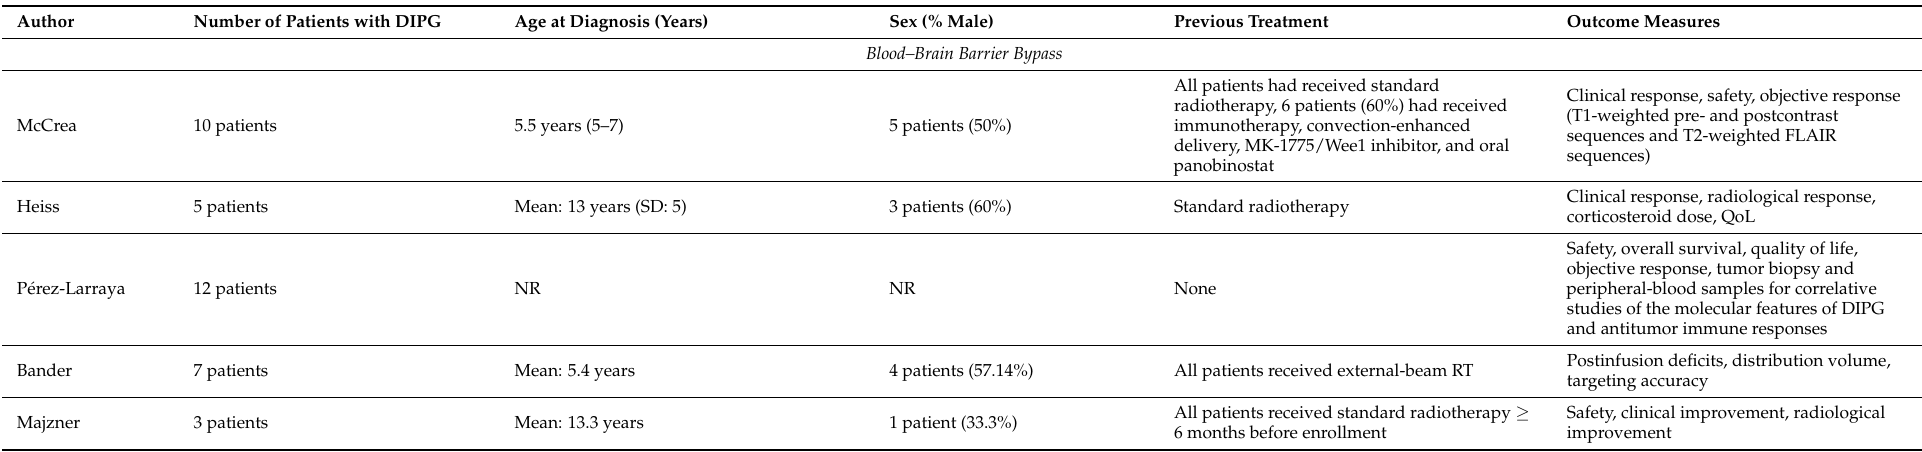
Table 2. Patient characteristics and outcome